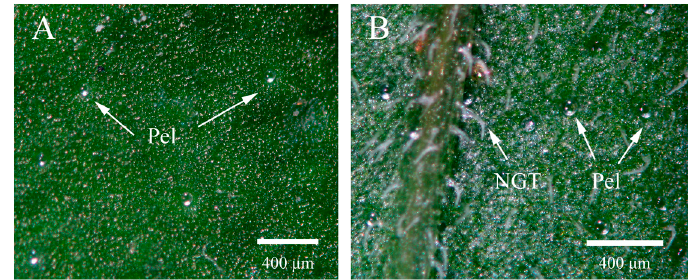
Figure 2. Stereomicroscope micrographs showing both sides of S. tenuifolia leaf. ( A ) Adaxial leaf surface with glandular peltate trichomes (Pels); ( B ) Abaxial leaf surface with non-glandular trichomes (NGTs) and glandular peltate trichome (Pels).